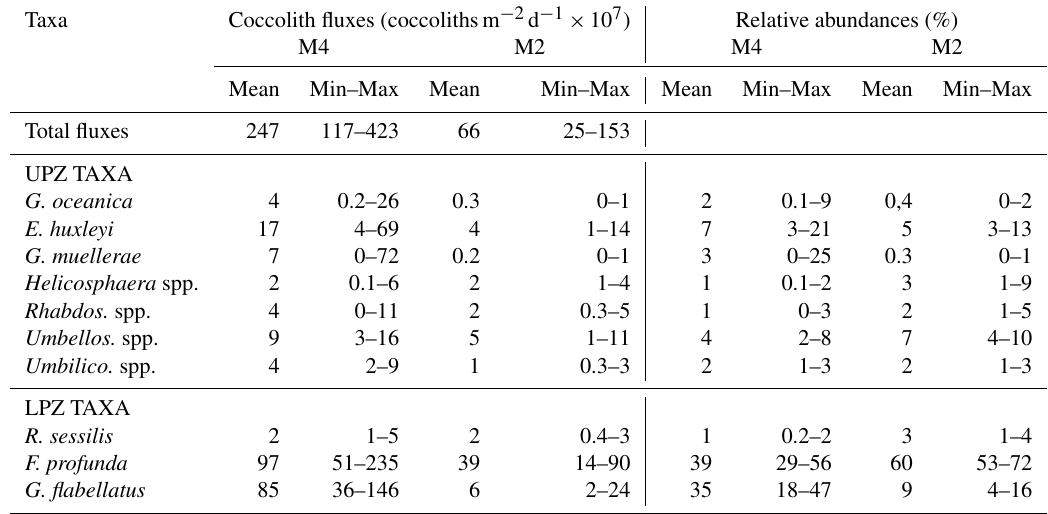
Table 2. Annual mean and range of coccolith fluxes and relative abundances of the most abundant coccolithophore taxa (mean > 2%) for mooring stations M4 (left) and M2 (right). Loadings marked in bold refer to the strongest significant correlations ( r ≥ 0 .